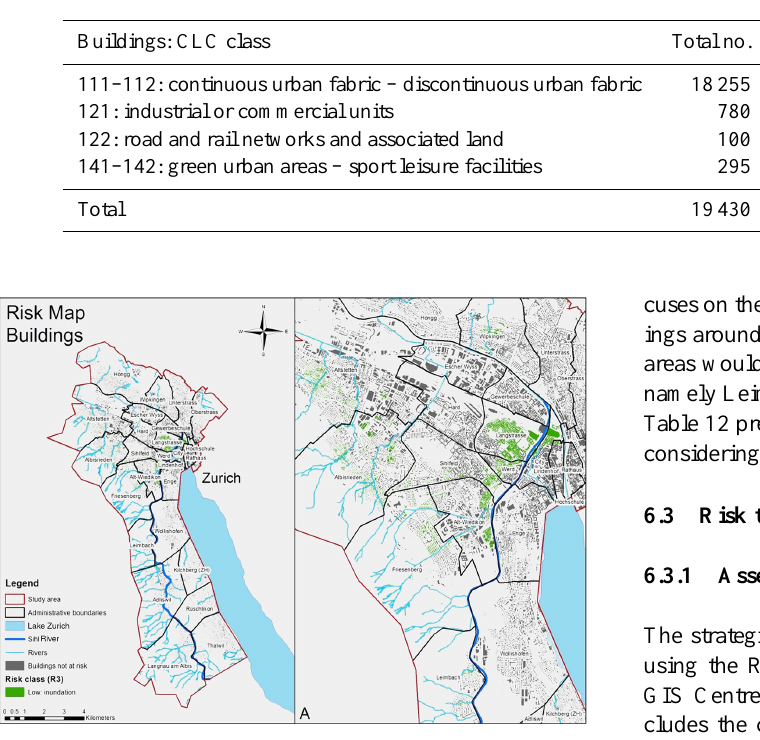
Table 10. Statistics about the buildings coverage along the Sihl River valley.